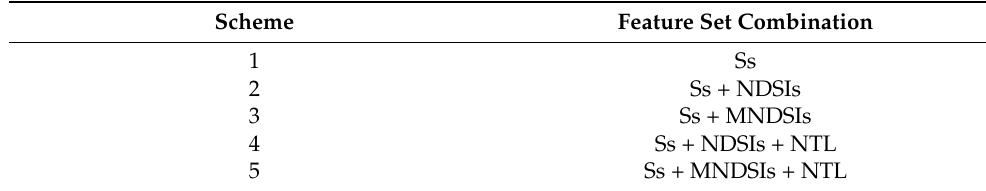
Table 2. Feature set combination